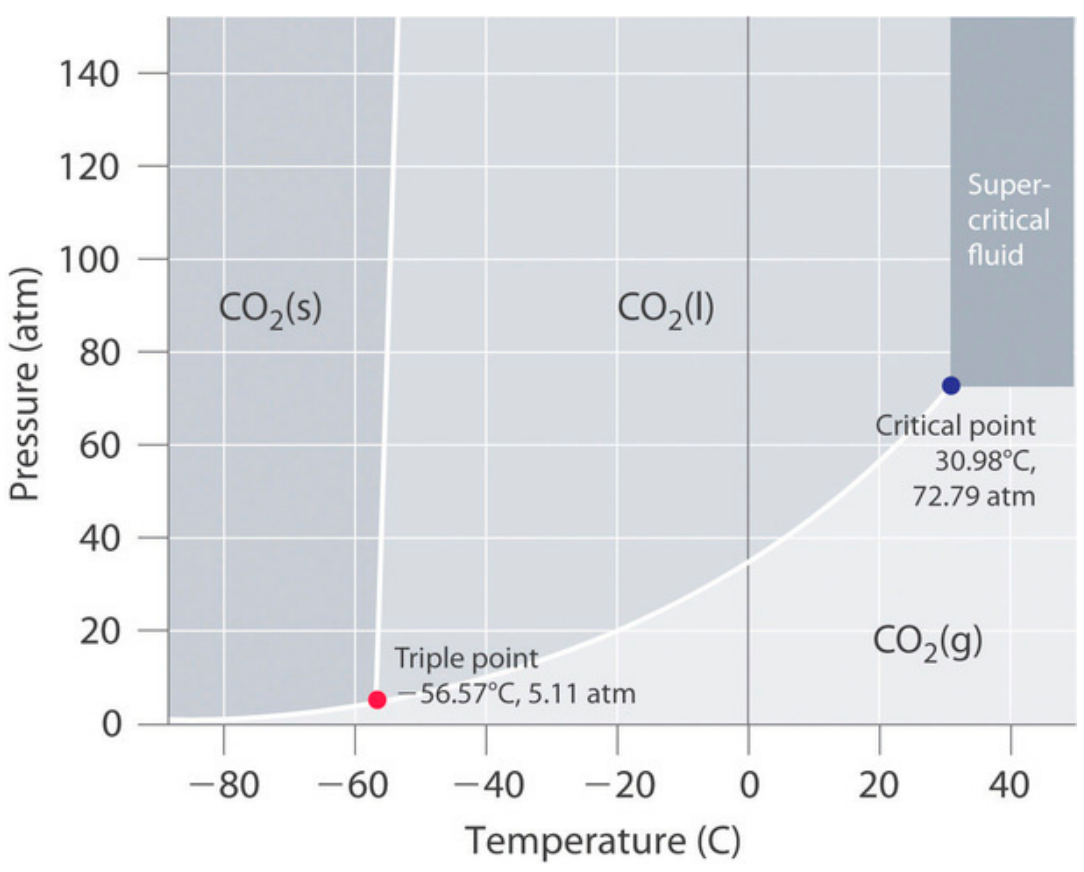
Figure 2. Carbon dioxide pressure–temperature curve.